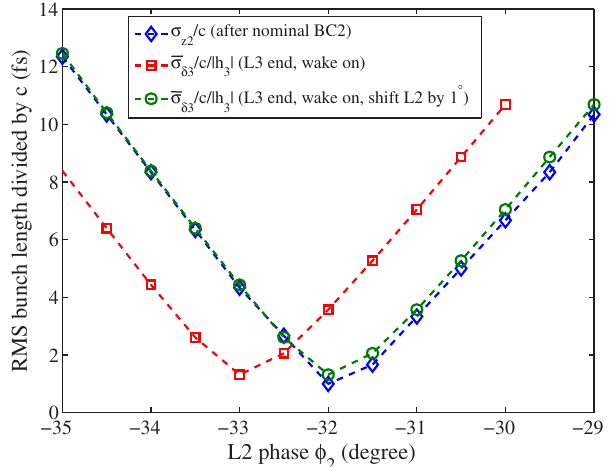
FIG. 4. LITRACK simulations of rms bunch length for the LCLS 20-pC bunch after BC2 (5% area cut in current or energy distributions). The nominal BC2 R 56 ¼ (cid:2) 24 : 7 mm , and R 56 ¼ (cid:2) 31 : 88 mm for the bunch length